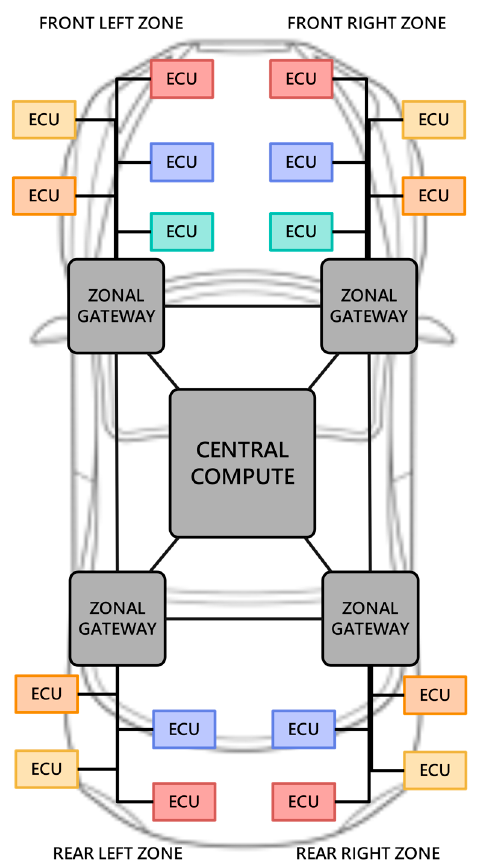
Figure 2. Body structure of zonal IVN architecture. The network is replaced in physical space, includes left front zone, right front zone, left rear zone, and right rear